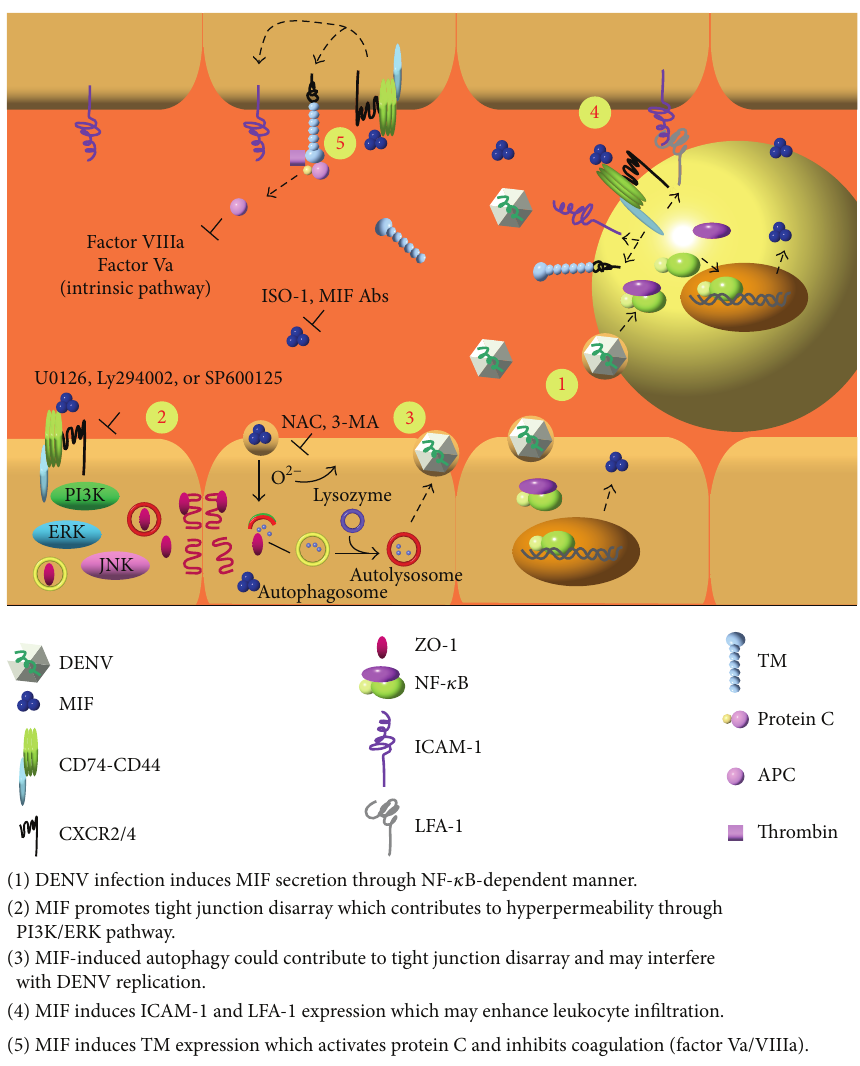
Figure 1: Schematic diagram of the pathogenic roles of MIF and possible strategies to block its effects during DENV infection. MIF expression is upregulated during DENV infection. Blocking MIF function by a MIF inhibitor (ISO-1) or MIF antibodies or its signal transduction by U0126 (Erk inhibitor), Ly294002 (PI3K inhibitor), or SP600125 (JNK inhibitor) may prevent MIF-induced permeability. In addition, MIF- induced autophagy may enhance DENV replication; therefore, blocking autophagy by NAC (ROS scavenger), 3-MA (autophagy inhibitor), or a MIF inhibitor (ISO-1) may reduce DENV replication. In addition, MIF induces the upregulation of ICAM-1 and LFA-1 expression, which may influence leukocyte recruitment. Finally, TM expression induced by MIF may activate protein C and inhibit thrombin formation. These effects of MIF can be blocked by its inhibitor or an